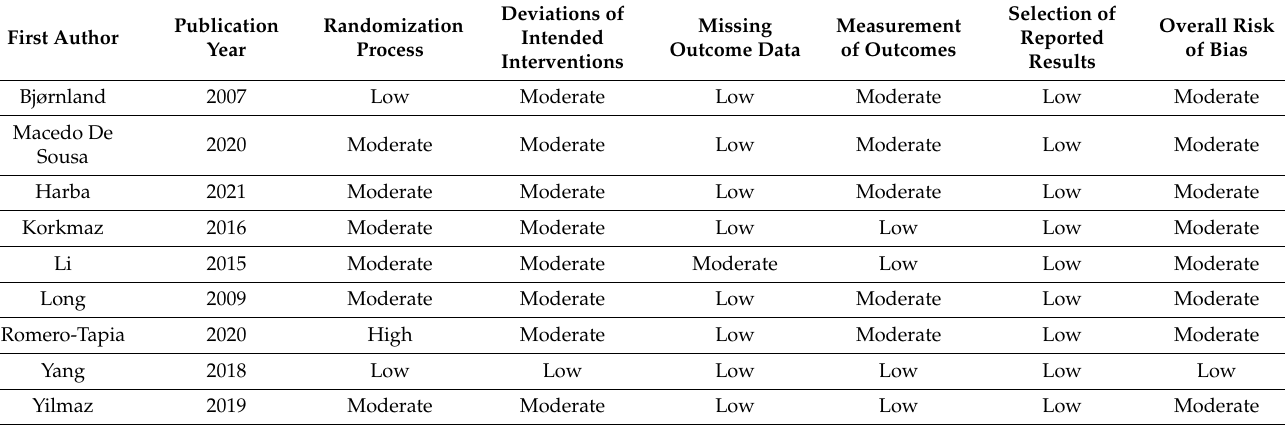
Table 5. The assessment of the risk of bias in individual studies. N/A—not